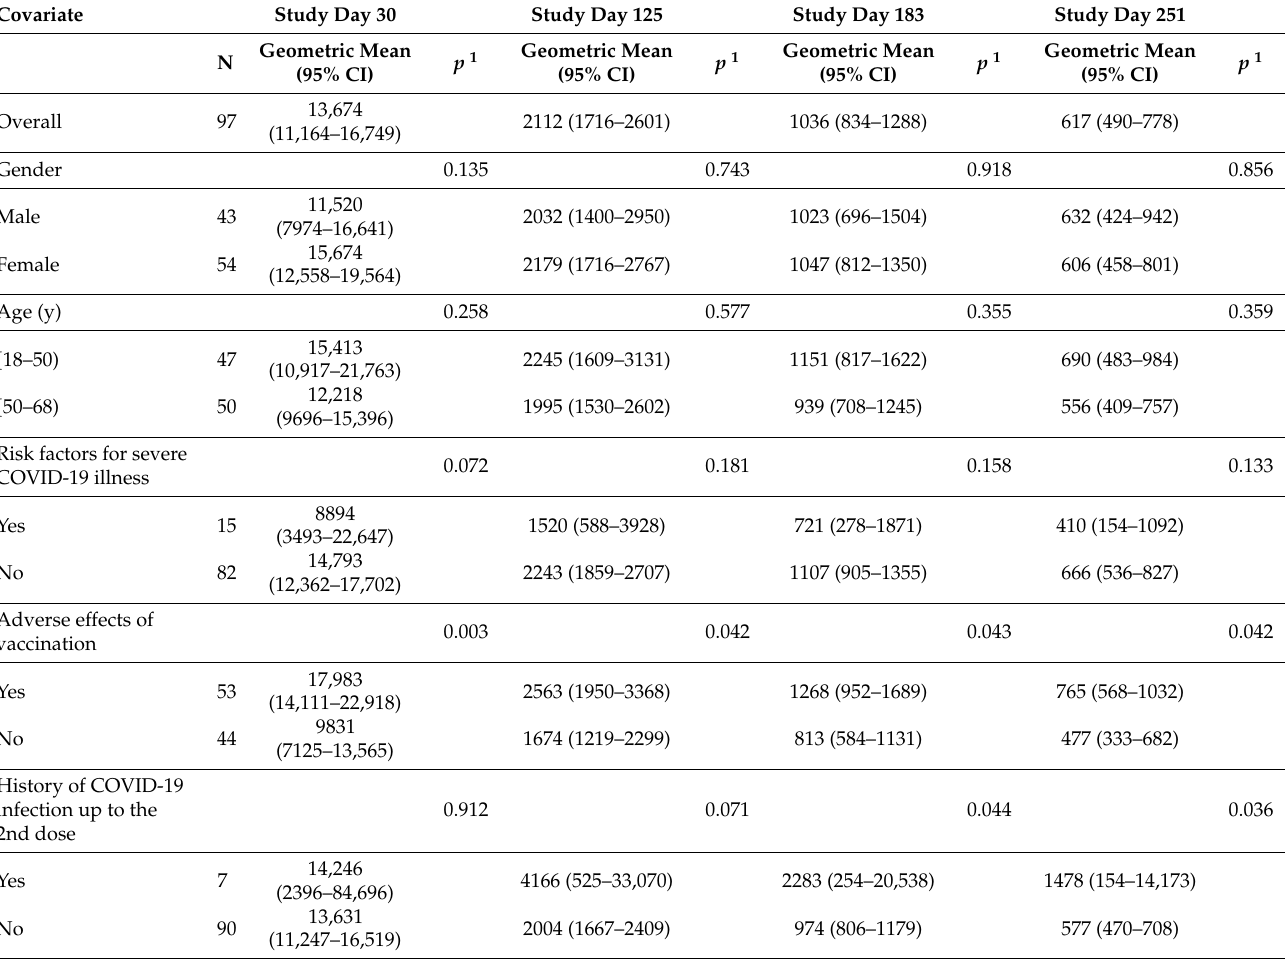
Table 2. Geometric mean with 95% confidence interval (AU/mL) concentration of anti-SARS-CoV- 2 RBD IgG antibodies at four time points after the first dose of BNT162b2 vaccine by different characteristics, n =